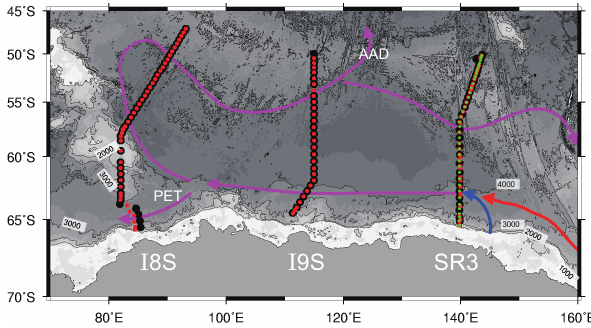
Fig. 1. Locations of the WOCE WHP (black circles) and their repeat (red and green circles) meridional hydrographic sections crossing the Australian-Antarctic Basin with schematic view of spreading path of the AABW. Red circles on SR3 show locations of repeat occupations in the year 2001 (50–61 ◦ S), 2002 (61–66 ◦ S), 2003 (61–66 ◦ S) and green circles show those in 2008, respectively. All the red circles on both I9S and I8S show repeat occupations in the 2000s. Red and blue arrows indicate the RSBW from the Ross Sea and ALBW from the AGVL region respectively and the AA-AABW is indicated by purple